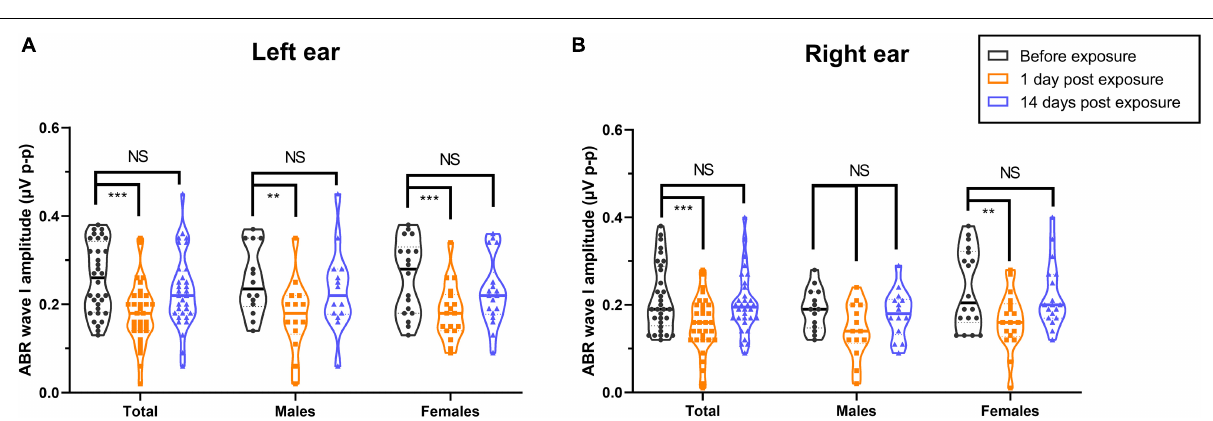
FIGURE 6 | Effects of noise exposure on ABR wave I amplitudes. The peak amplitude of wave I significantly decreased at 1 day after outdoor music festival noise exposure (orange) and recovered to the baseline level (black) at 14 days after exposure (blue) in the left (A) and right (B) ears of total participants and of females specifically, as well as in the left ear of males, but not in the right ear of males. Analyses were performed by the two-way repeated measures ANOVA. NS, no significance. ** P < 0.01, *** P <